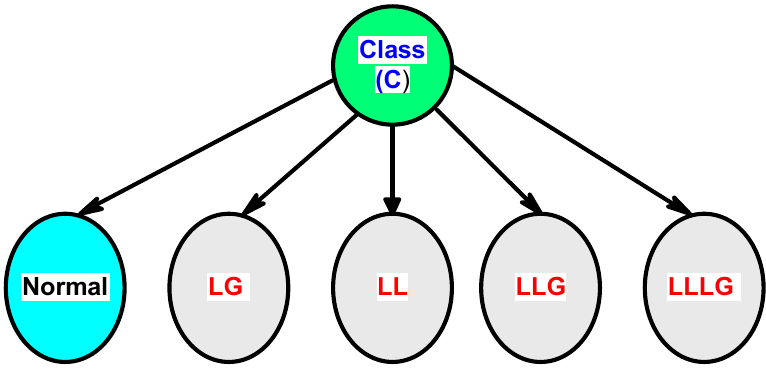
Figure 5. Naive Bayes (NB) classifier of the proposed work.